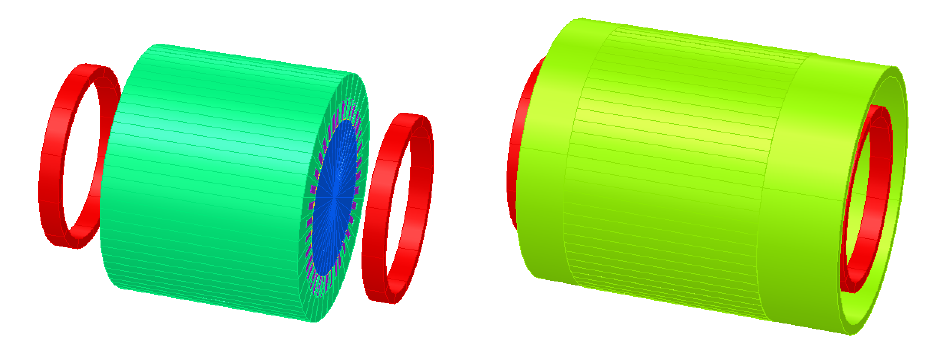
Figure 10. Induction motor with additional